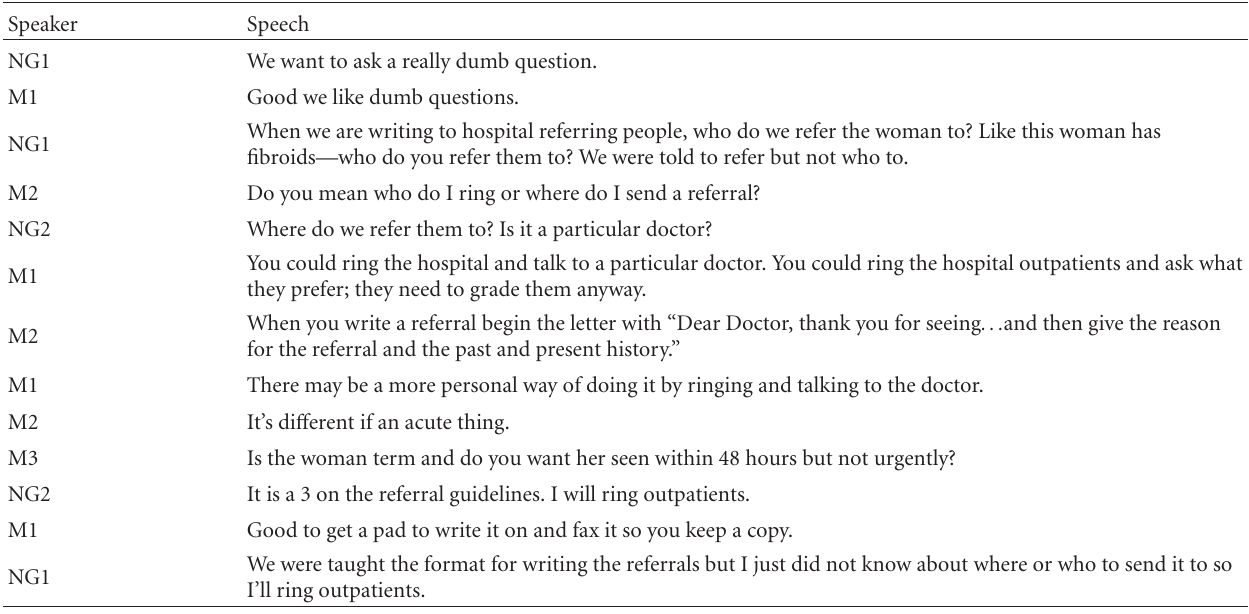
Table 2: Example of a thread of conversation (1st